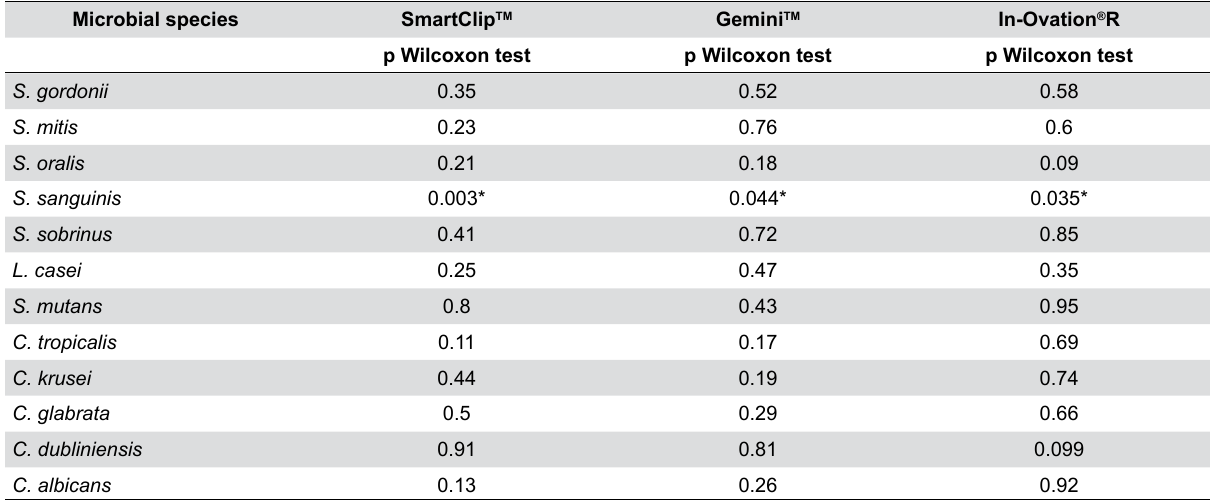
Table 4- Wilcoxon test for microbial levels in situ Microbial species